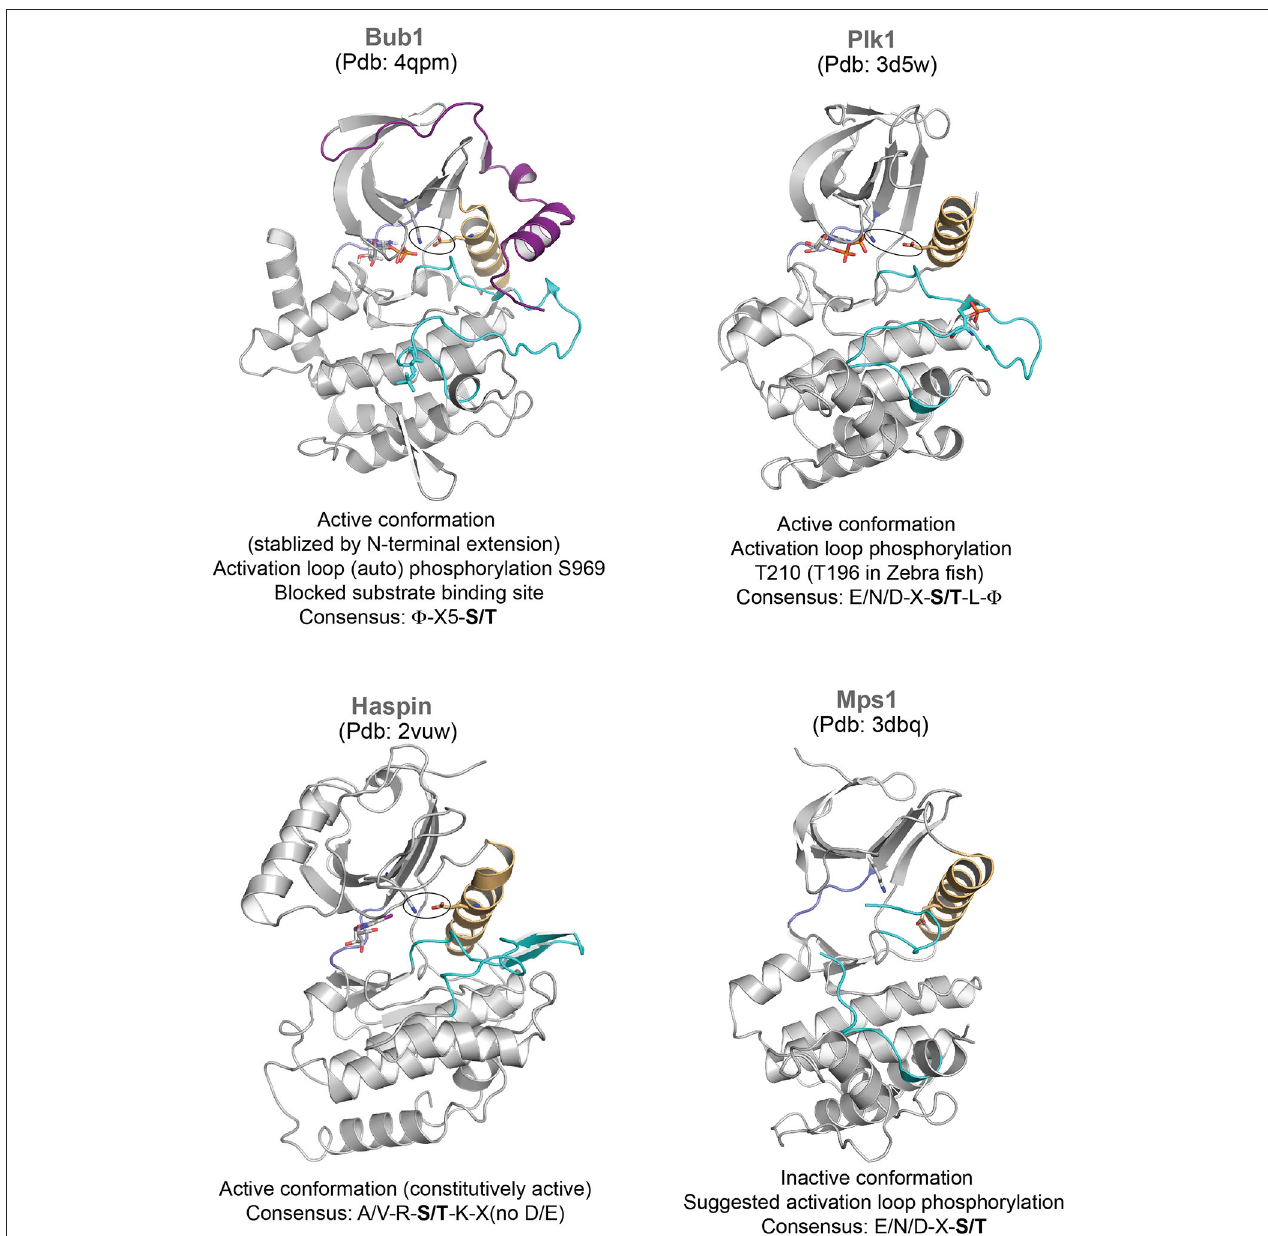
FIGURE 2 | Representative structures of mitotic kinases II. Key structural features are highlighted: C-helix (light orange), hinge region involved in ATP binding (blue), and activation segment (cyan). The characteristic structural feature of an active enzyme, the salt bridge between a Lys and Glu from the N-terminal lobe and the C-helix is highlighted in stick